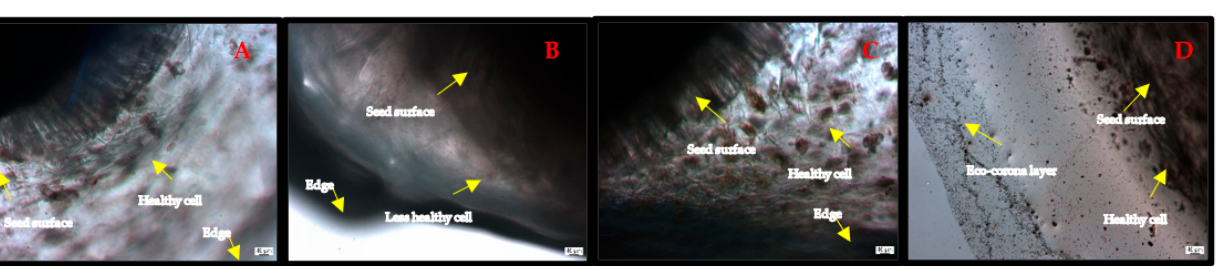
Figure 4. Microscopic image of ( A ) control ( B ) PS, ( C ) HA, and ( D ) PS + HA on Solanum lycopersicum seeds. PS interacted seed after 24 h microscopic image shows a smaller number of healthy cells on the surface of the seed, Control, and HA microscopic image shows a higher number of healthy cells presences on the surface of the seed and PS + HA interacted seed microscopic image show presences of a higher number of healthy cells and on the surface of the seed eco-corona layer was observed.